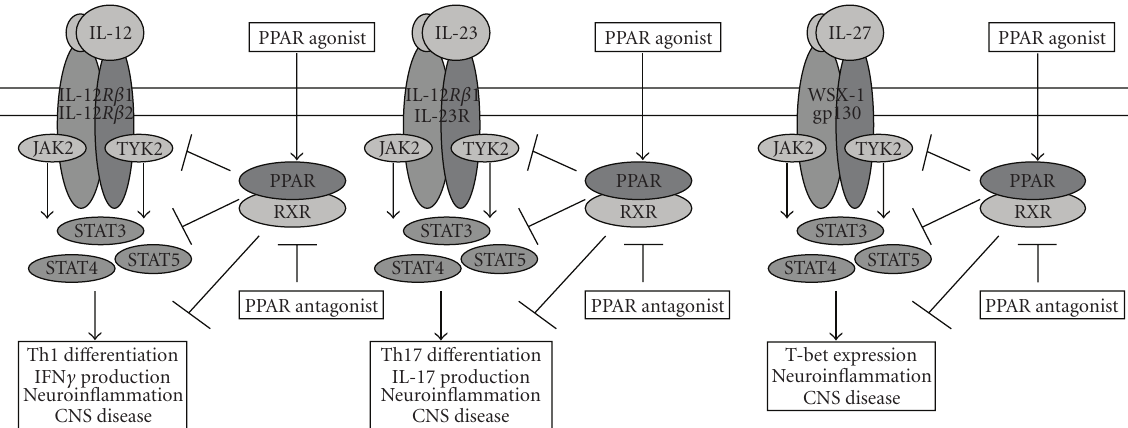
Figure 4: IL-12, IL-23 and IL-27 are heterodimeric cytokines signals through Jak-Stat pathway and induce Th1/Th17 di ff erentiation and T-bet expression in T cells. Treatment with PPAR agonists regulate these responses in T cells resulting in inhibition of CNS inflammation.